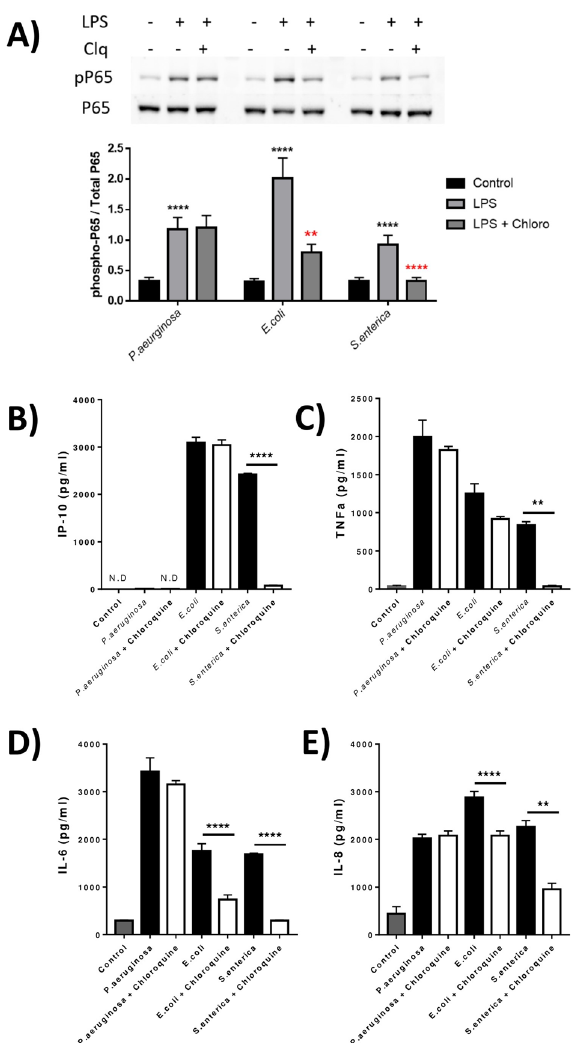
Figure 3. E. coli and S. enterica , but not P. aeruginosa LPS signal partially via the endosome in polarized macrophages resulting in altered inflammatory cytokine production. Differentiated M1 THP-1 macrophages were stimulated with LPS from P. aeruginosa , E. coli or S. enterica with or without pre-incubation with 100 µM Hydroxy-Chloroquine. Induction of ( A ) LPS induced P65 phosphorylation measured after 30 min with/ without Clq (Hydroxychloroquine). ( B – E ) IP-10, TNFα, IL-6 and IL-8 production was measured in conditioned supernatants. Data is expressed as the mean ± SEM of 3 independent differentiations of THP-1